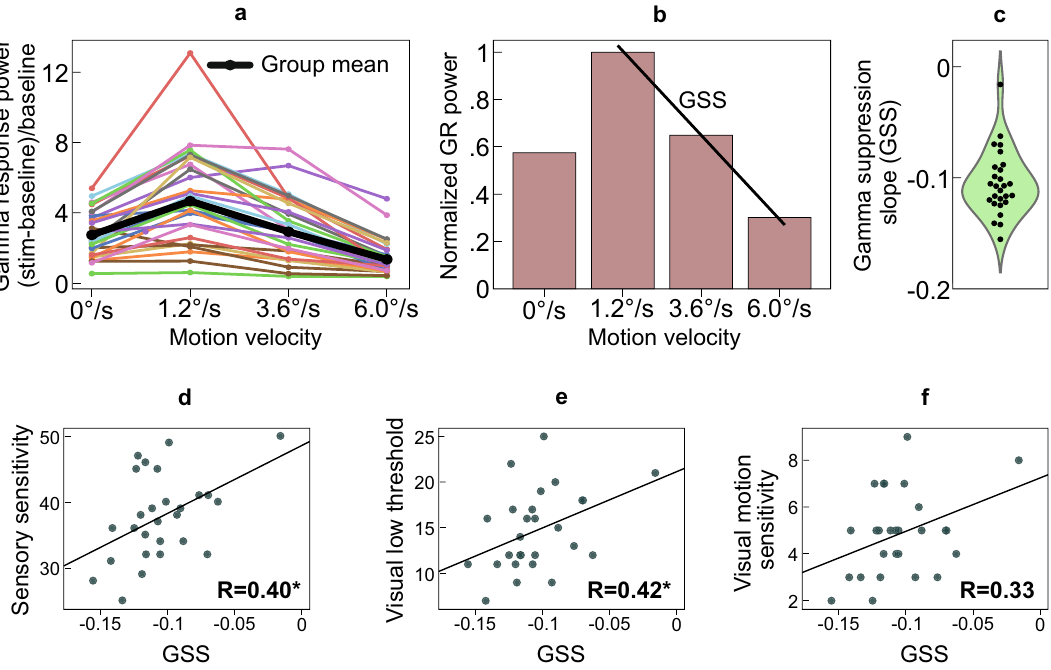
Figure 2. Attenuation of the gamma response (GR) power with increasing motion velocity of the grating (i.e., the Gamma Suppression Slope, GSS) and its correlations with Adolescent/Adult Sensory Profile (A/ASP) scales. ( a ) Lines representing the changes in the GR power at each velocity and for each participant, as well as the group mean (thick black line). ( b ) Group average GR power normalized to the ‘maximal GR’ (usually GR in the ‘slow’ condition). The line illustrates the GSS that quantifies the magnitude of velocity-related GR attenuation. ( c ) Violin plot of the GSS values. ( d – f ) Correlations between the GSS index and three A/ASP sensitivity scales: ( d ) ‘Sensory Sensitivity’, ( e ) ‘Visual Low Threshold’, ( f ) ‘Visual Motion Sensitivity’. R’s are Spearman rank correlation coefficients, *p <